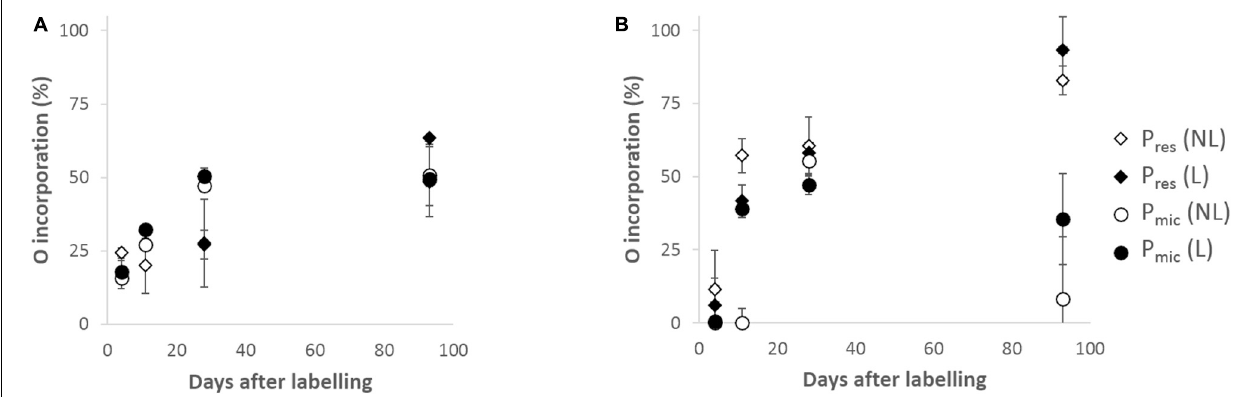
FIGURE 3 | Oxygen incorporation from water into available P (P res ) and microbial P (P mic ) pools according to Equation 5 in Lüss (LUE; A ) and Bad Brückenau (BBR; B ) soils during the incubation. Error bars indicate standard deviation from Monte Carlo error propagation. NL, non-amended; L, leaf litter-amended.